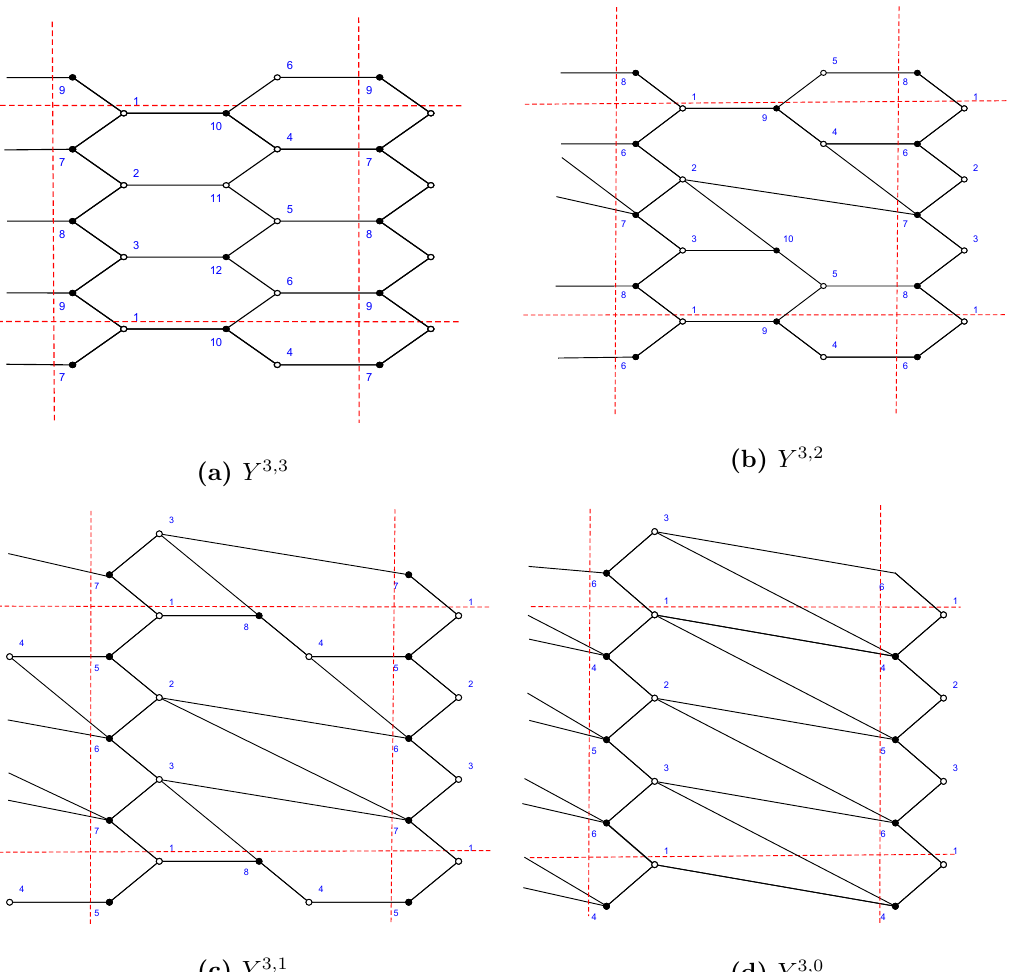
Figure 3. Brane tiling for Y 3 ;q ; q = 3 ; 2 ; 1 ; 0, the unit cells are divided by the red dashed lines, which are the loops (cid:13) X;Y on the